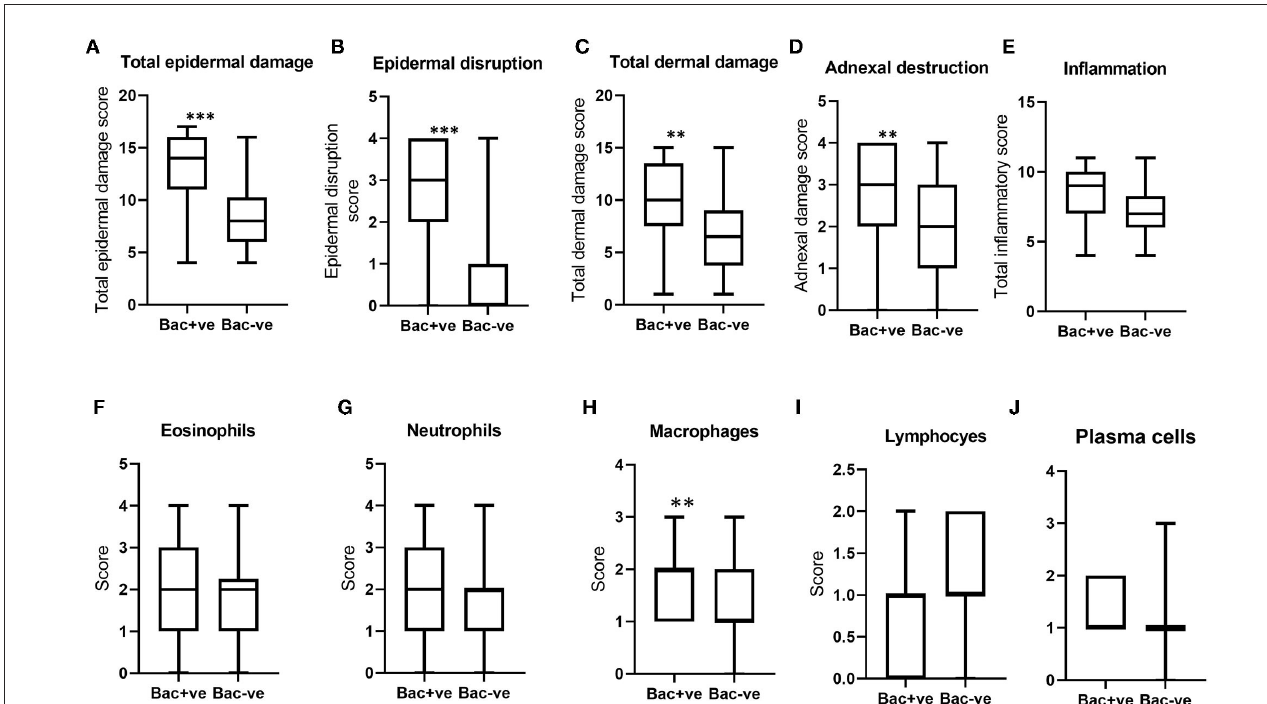
FIGURE6 Boxplots (A–D) indicate the distribution of scores for total epidermal damage, epidermal disruption, total dermal damage and adnexal destruction for bacterial positive (Bac + ve) and negative (Bac-ve) lesions. Boxplots (E–J) show total inflammation and individual inflammatory cell scores of these two groups (** P < 0.01, *** P < 0.001).